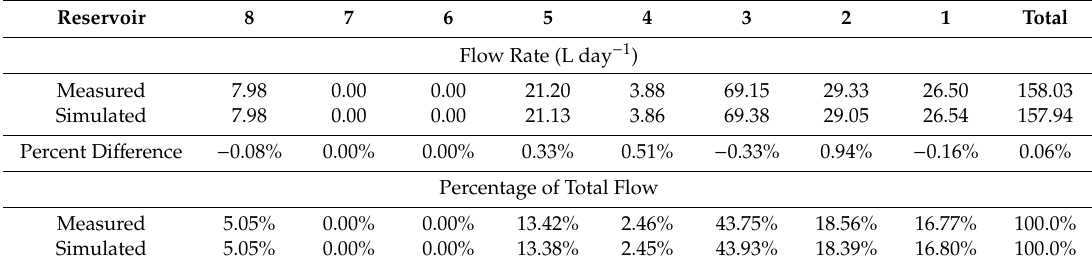
Table 5. Results for the measured versus simulated drainage